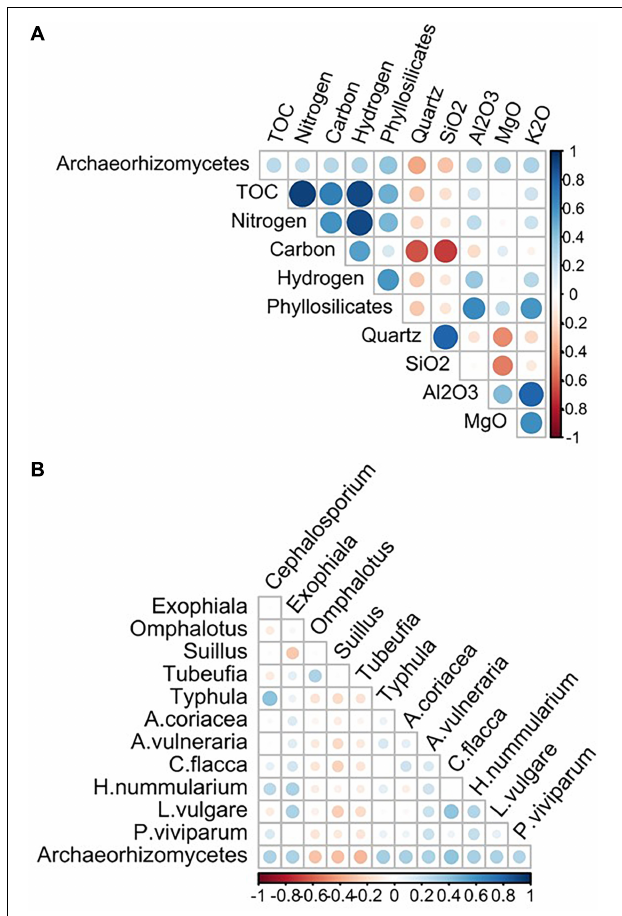
Supplementary Table S9 . TOC, total organic carbon; Al 2 O 3 , aluminum oxide; gdd, growing degree-days; psum, sum precipitation days/growing season; etp, potential evapotranspiration; tmin, minimum monthly average